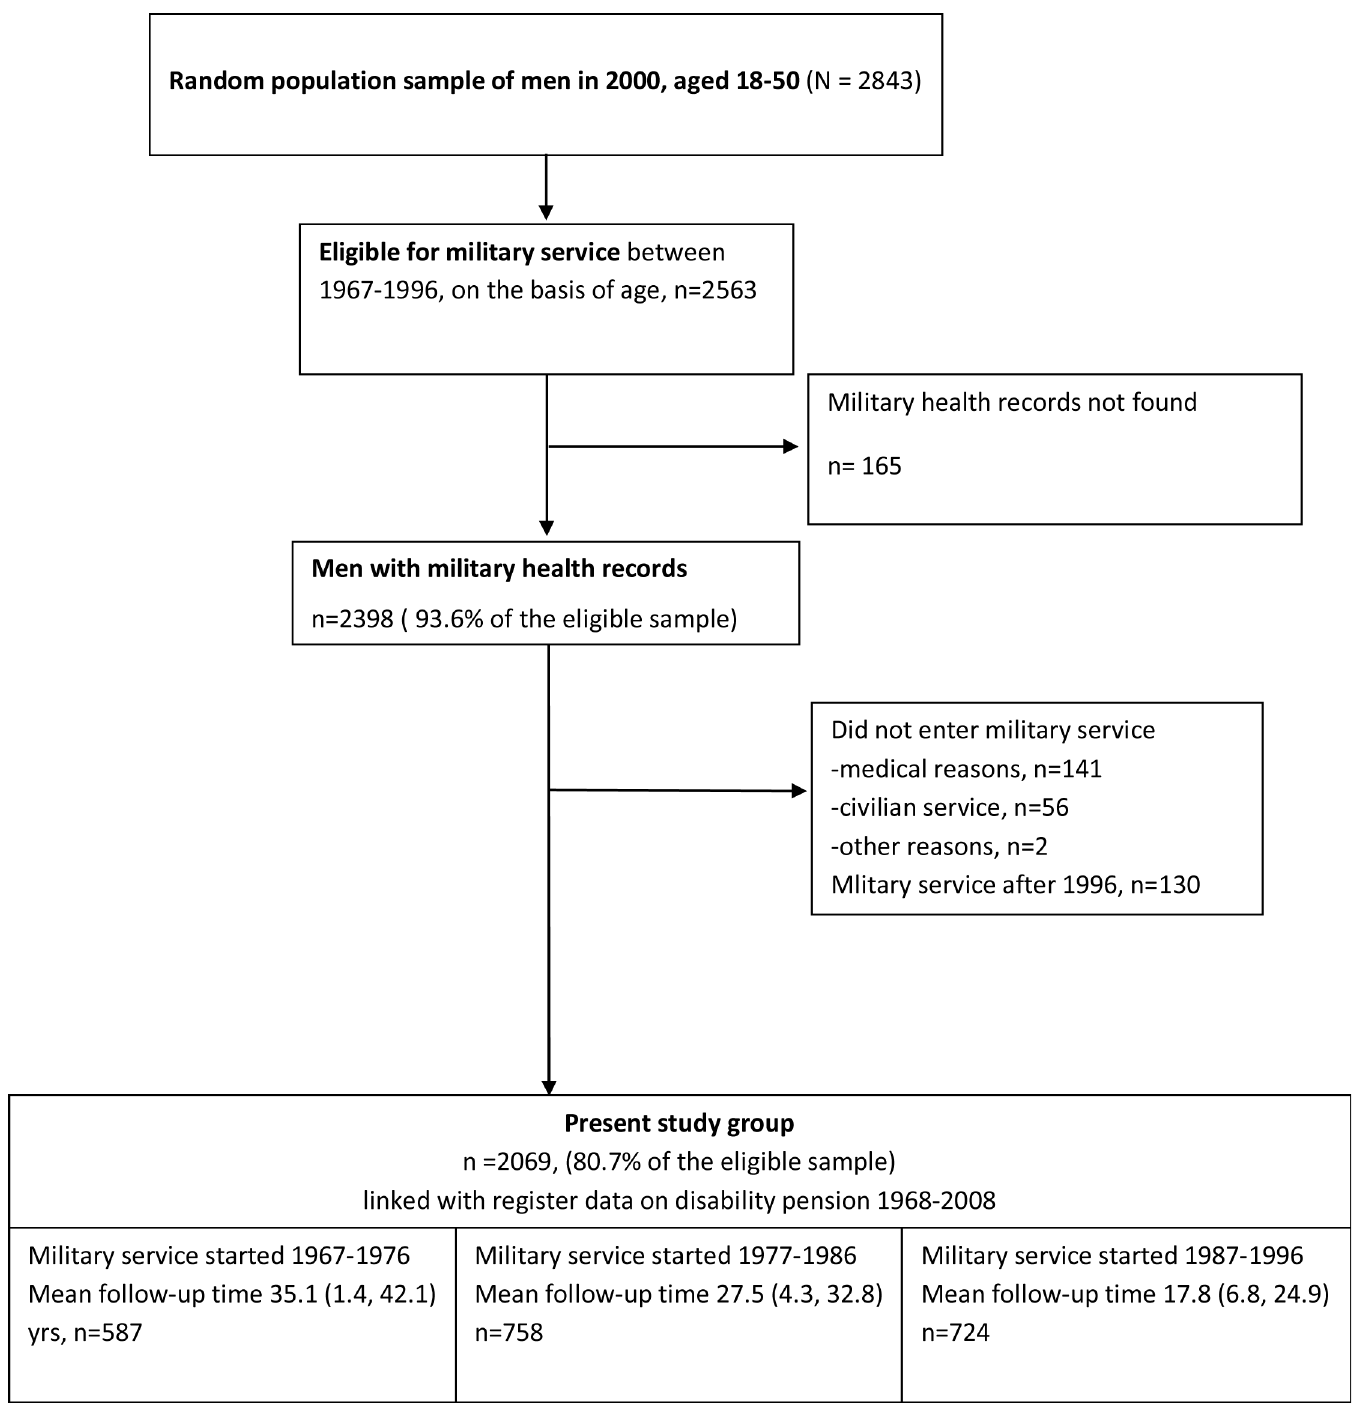
Fig 1. Flowchart of the Present Study